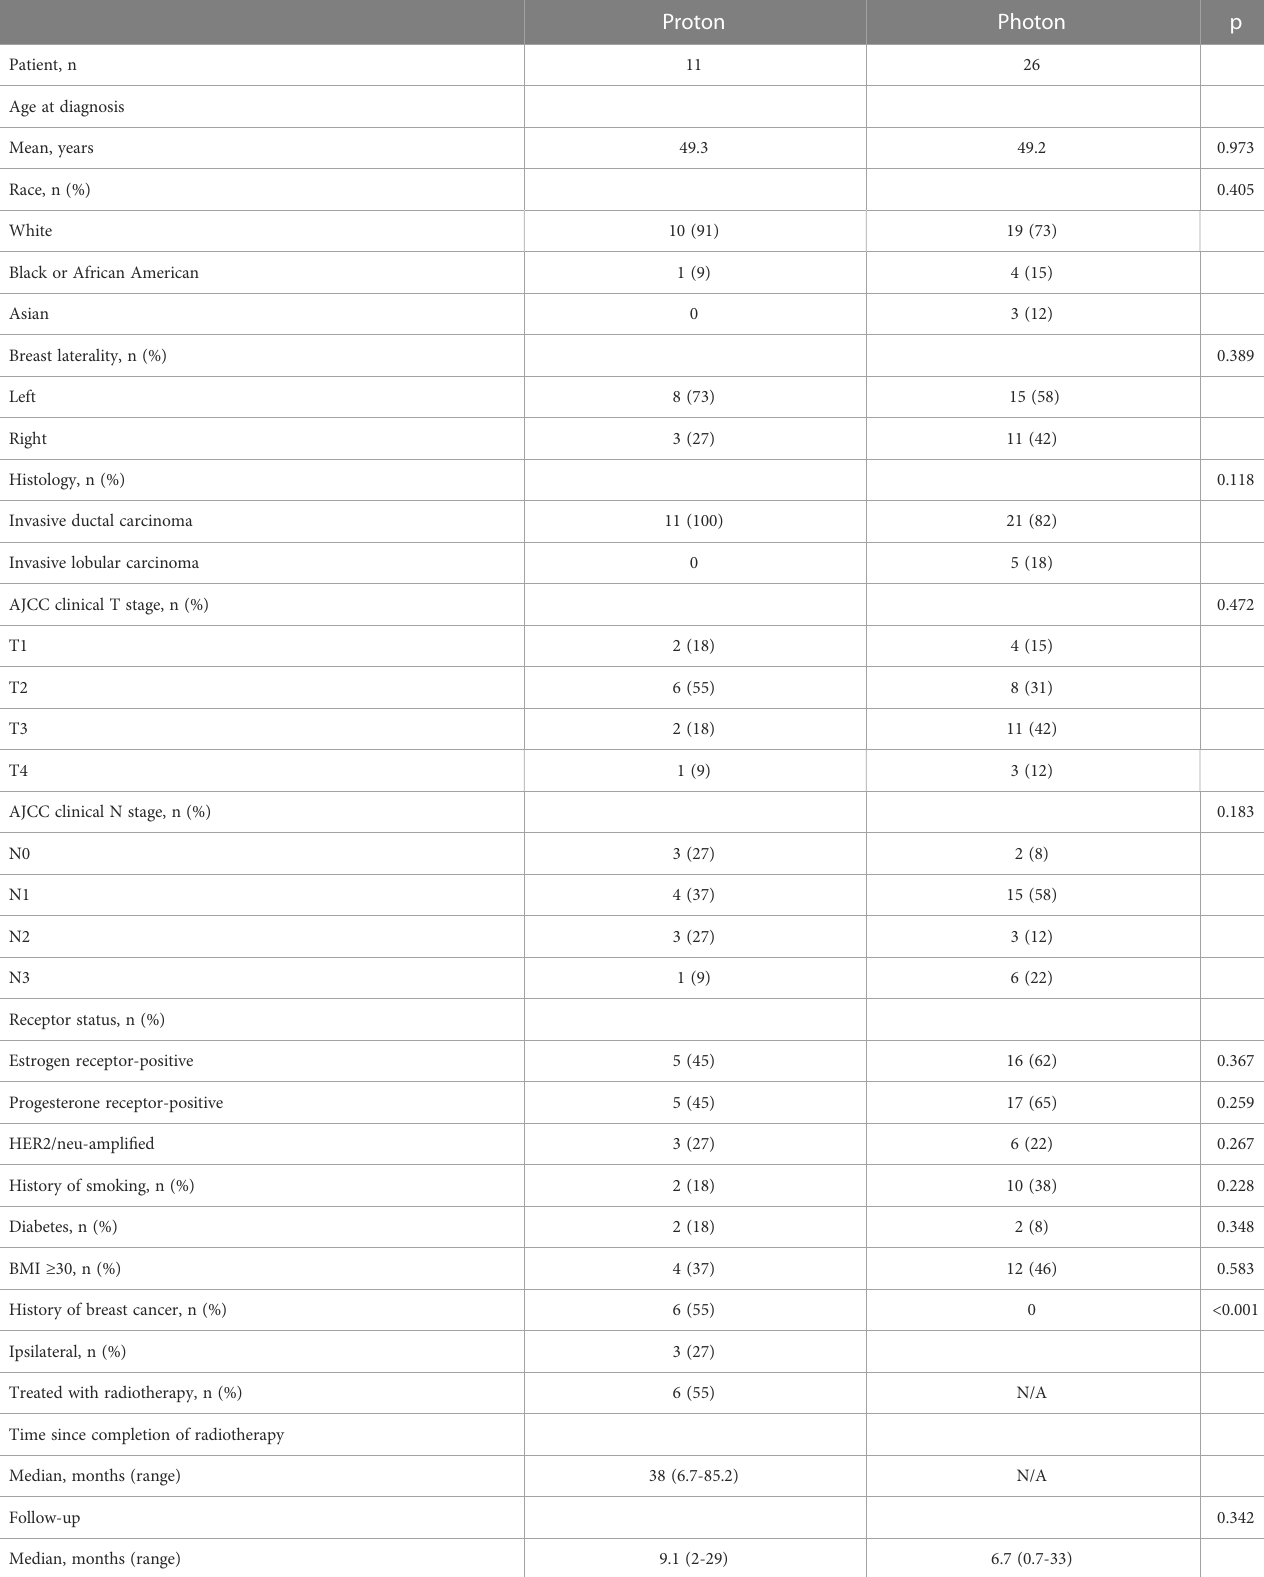
TABLE 1 Baseline